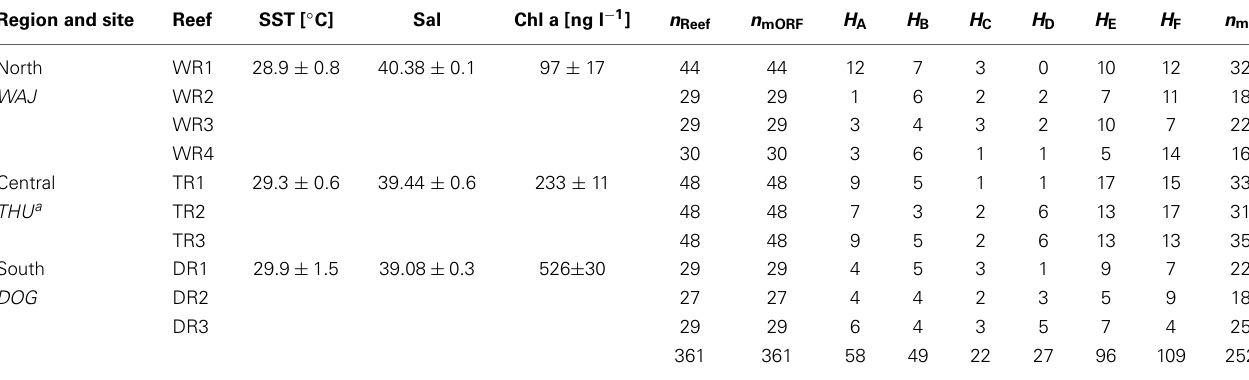
Table 1 | Sampling sites, environmental conditions, and number of samples for mitochondrial ( mORF ) and nuclear (ms) marker analyses. Region and site